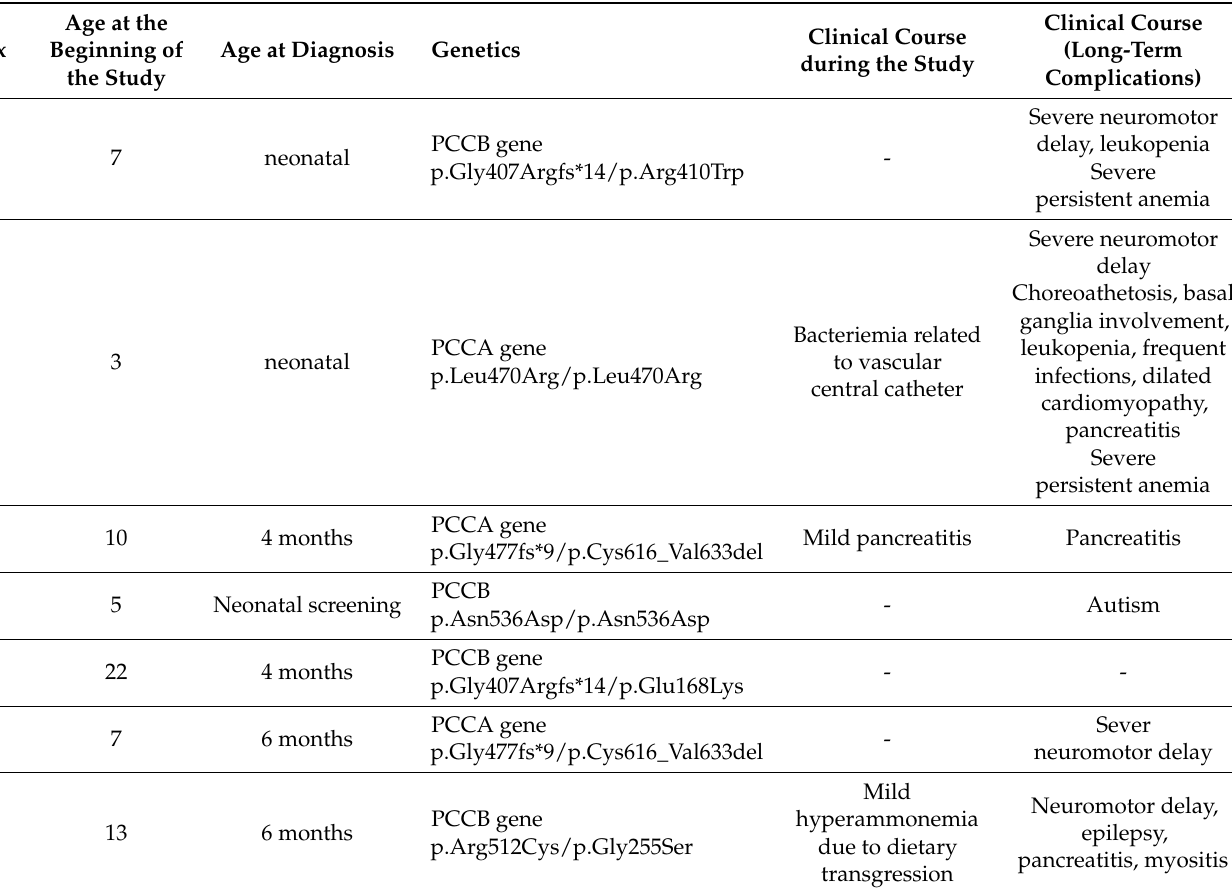
Table 1. Patient demographic and clinical characteristics.